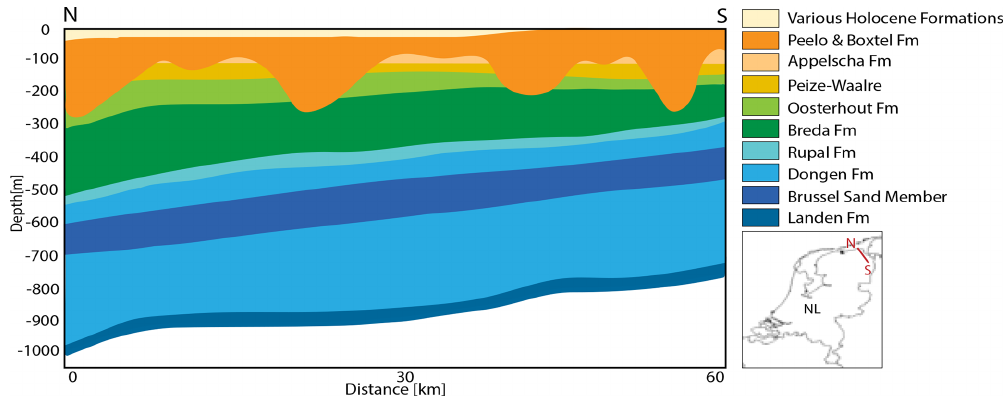
Figure 1. Schematic cross section of the North Sea Group (NSG) based on formation depths from https://www.dinoloket.nl/ (last access: January 2020) and stratigraphic charts (Wong et al., 2007). The formations of the Lower NSG have blue colours, formations of the Middle NSG are in green, and Quaternary formations of the Upper NSG are in orange/yellow. From the different members in the Lower NSG, only the Brussel Sand Member is included due to its importance for this